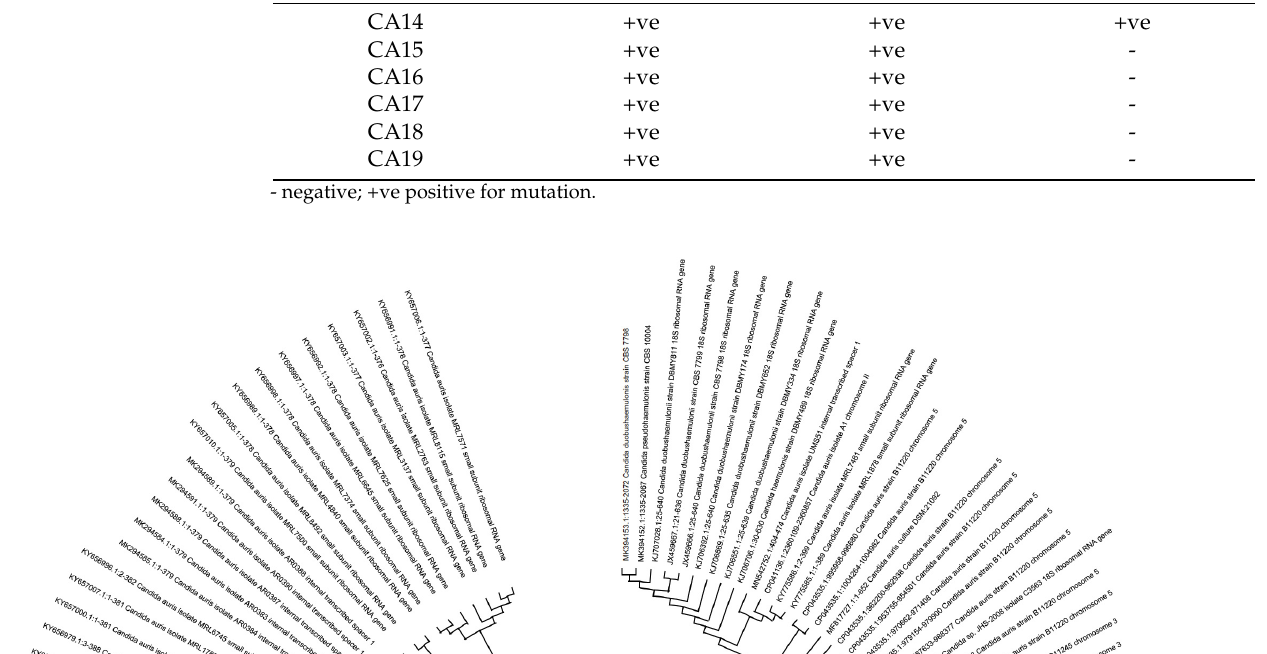
Table 1. Cont. Strain No.